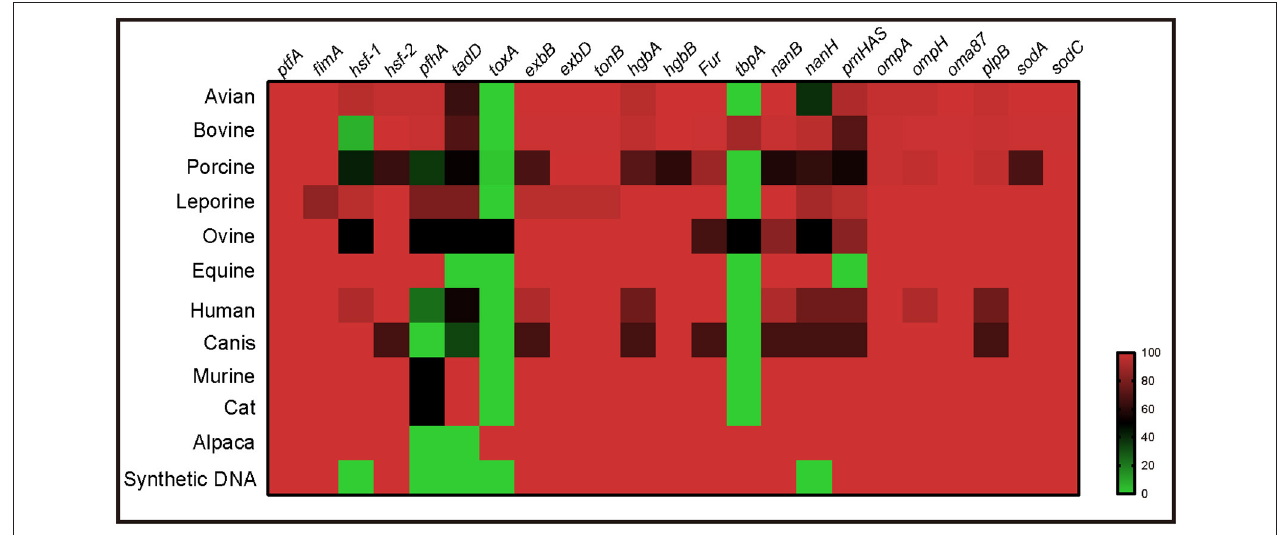
FIGURE 5 | Heatmap revealing the association between virulence genes and P. multocida strains from different host